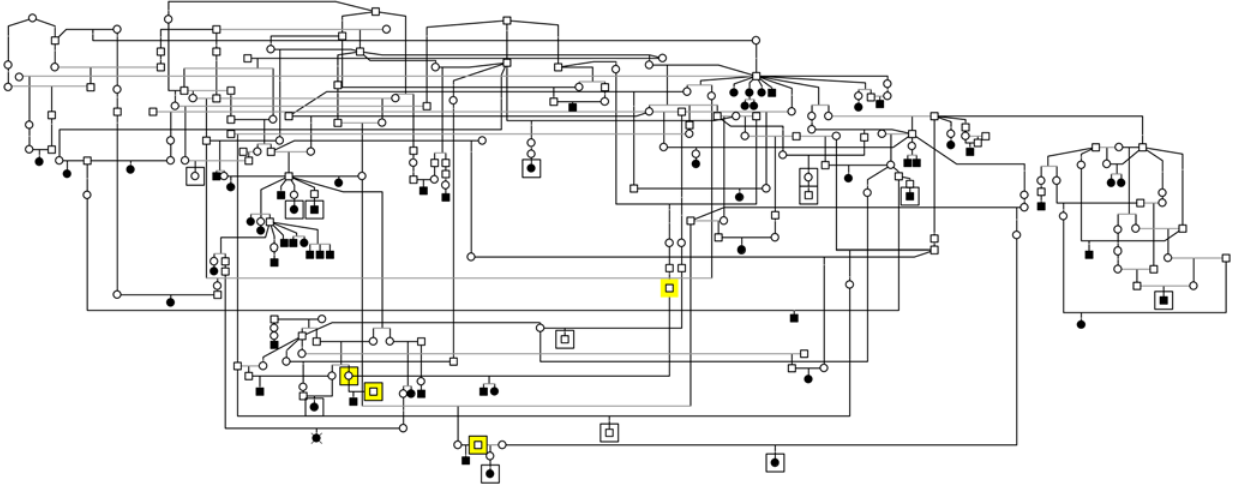
Fig 1. Pedigree of glaucoma affected Norwegian Elkhounds. The pedigree constructed around affected dogs indicates a likely recessive mode of inheritance as the affected dogs are born to unaffected parents and there are multiple affected littermates in some litter. The squared dogs were included in the GWAS. Individuals marked with yellow background were genotyped as obligatory carriers and were all heterozygous for the